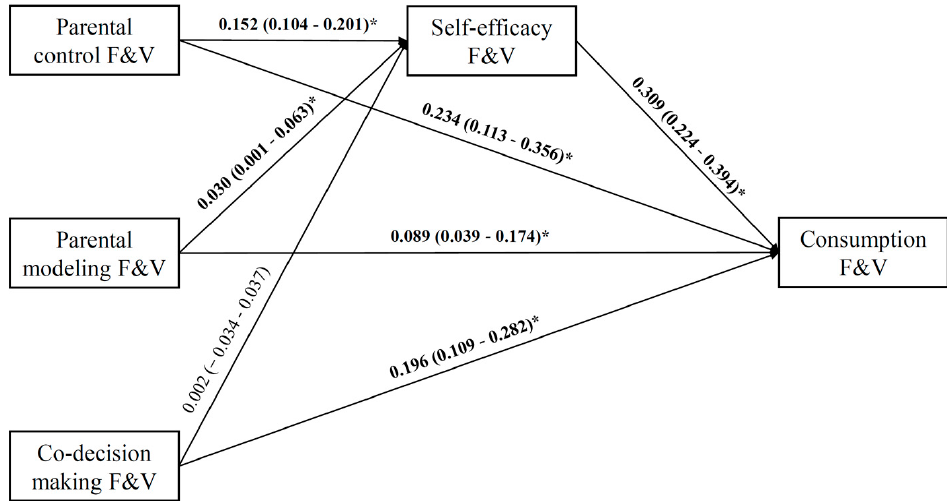
Figure 2. Path model of adolescents’ fruit and vegetable (F&V) consumption, adjusted for adjusted for age, gender, adolescents’ educational level, parental education level, monthly house-hold income, perceived health status, perceived weight status, perceived peer influence, BMI, and physical activity. β -coefficient and 95% CI are in parentheses. Significant results are bolded. * p < 0.05.